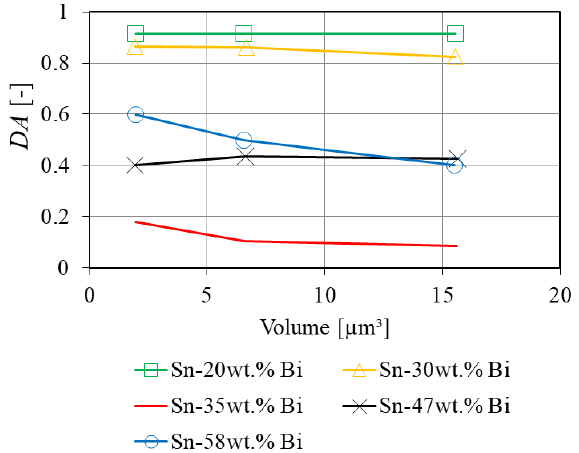
Figure A6. Degree of anisotropy over variation of VOI and alloy composition.